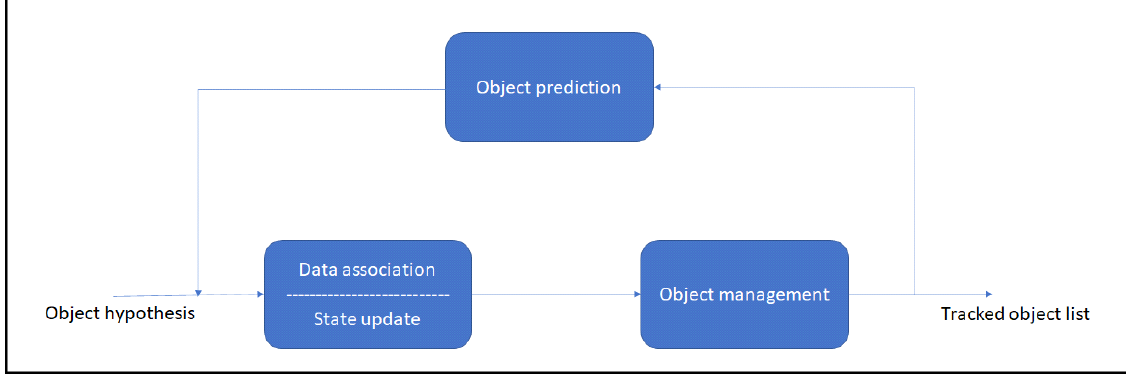
Figure 5. Architecture of multi-object tracking.